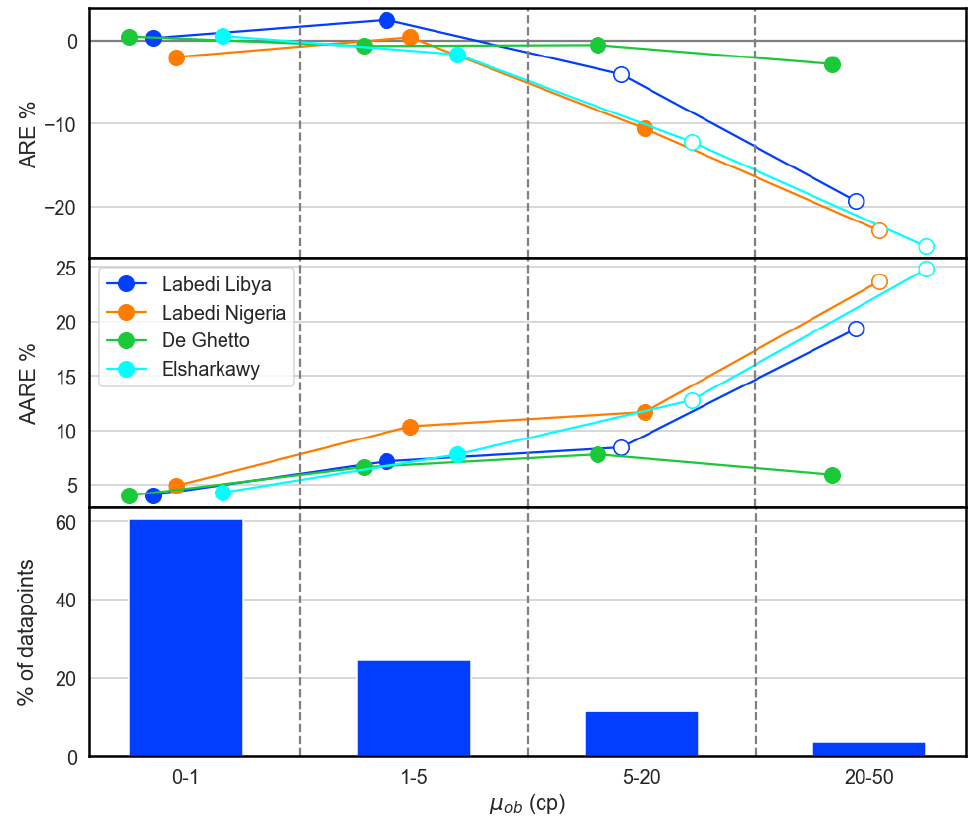
Figure 6. Evaluation of correlations in cluster B 1 (hollow points correspond to results obtained outside the development range of the